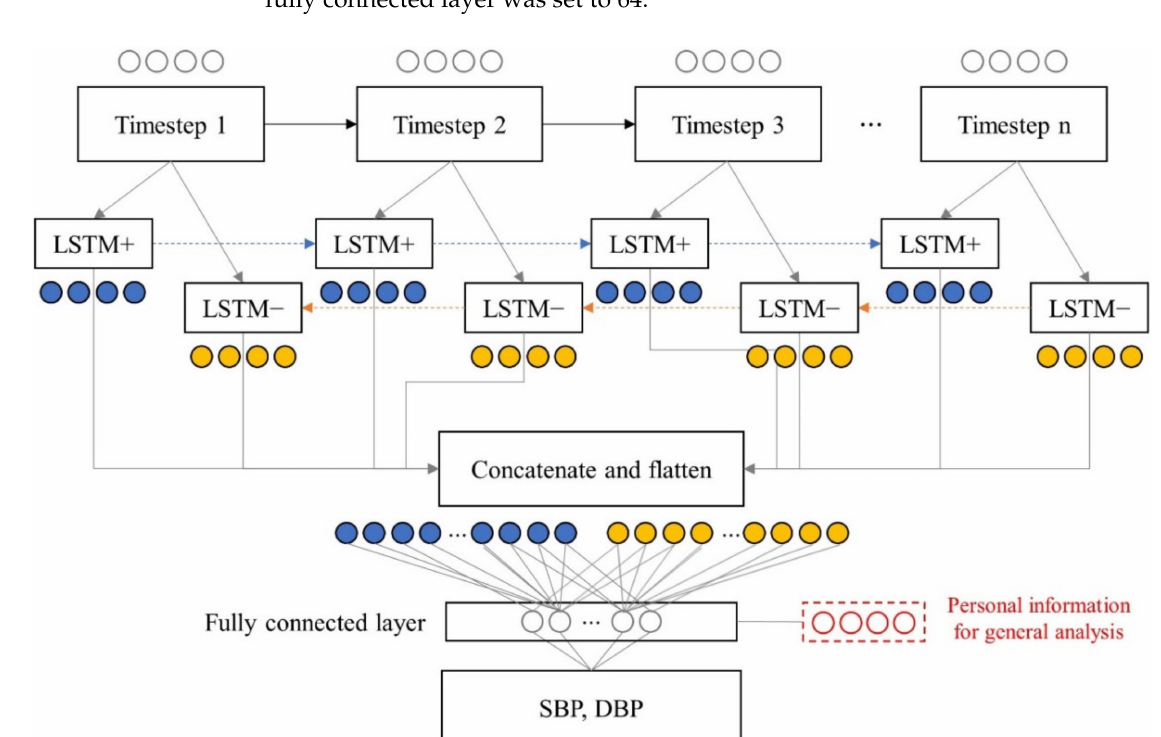
Figure 4. Diagram of proposed model